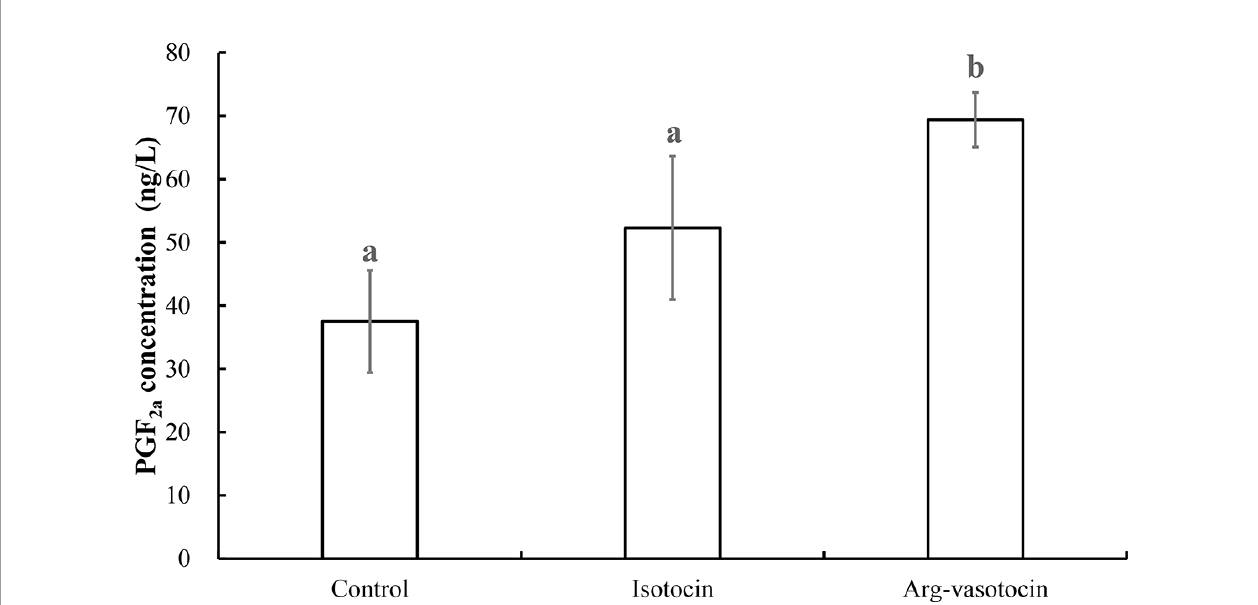
FIGURE 9 | Measurement of PGF 2a concentrations after IP injections of IT (1 m g/g), AVT (1 m g/g) or the same volume of saline (control). Eight individuals were analyzed in each group. Different lowercase letters indicate signi fi cant differences between the treatment groups (P < 0.05).